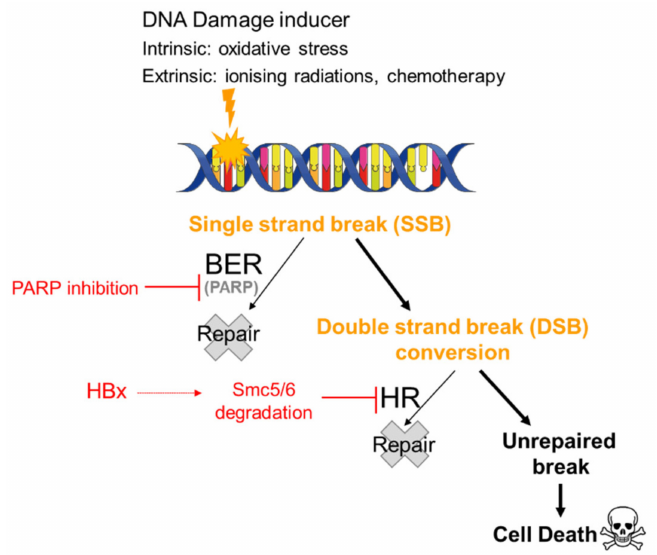
Figure 1. Synthetic lethality of PARP inhibitors in HBV-infected cells. It has been hypothesized that in a patient infected with HBV treated with PARP inhibitors, SSBs generated either intrinsically by oxidative stress or extrinsically by chemotherapy or radiotherapy remain unrepaired and are converted to DSBs. The impact of the degradation of the Smc5/6 complex by HBx on the HR pathway would result in the persistence of these DSBs and cell